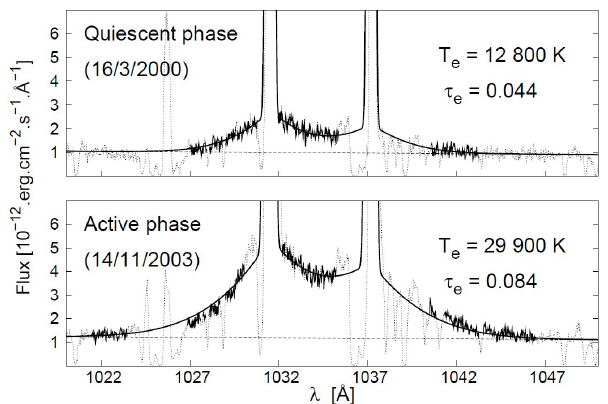
Figure 2: A model (solid line) of the observed (dotted line) profile of the OVI λ 1032, λ 1038˚A emission lines as a result of Thomson scattering in the spectra of AG Dra during active and quiescent phase.